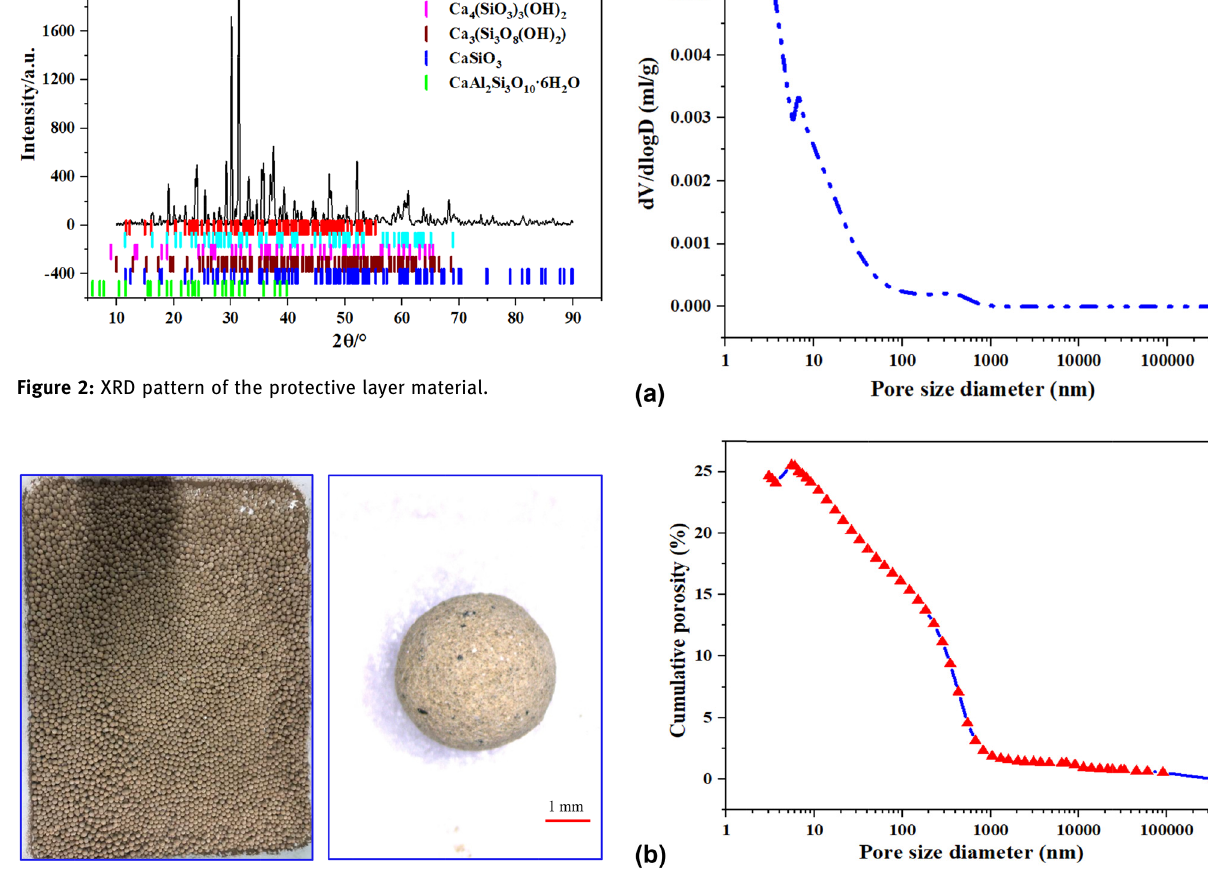
Figure 3: Morphology of the self - repairing carrier. Figure 4: Pore size distribution and cumulative porosity of the self - repairing carrier: ( a ) pore size distribution and ( b ) cumulative